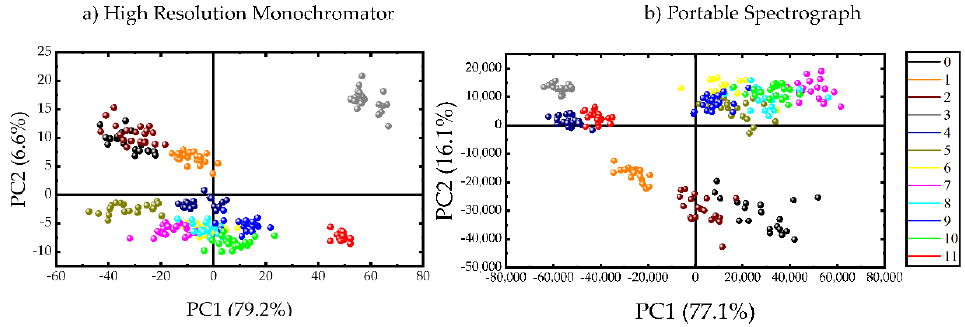
Figure 5. Scores plots of the spectra obtained from ( a ) the high-resolution monochromator and ( b ) the portable spectrograph.